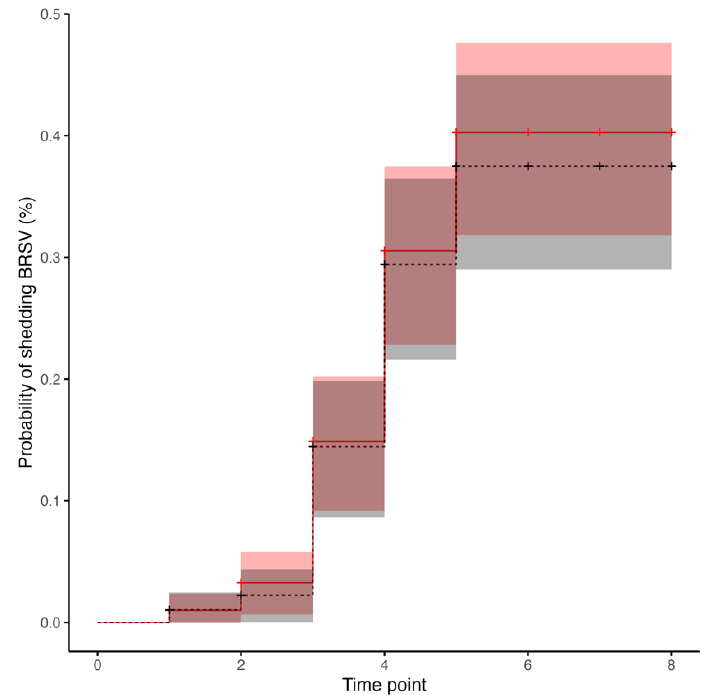
Figure 5. Kaplan–Meier curves of the cumulative probability of shedding Bovine Respiratory Syn- cytial virus (BRSV) detected by real time-RT-PCR assay on time intervals 0 to 8, in which each time interval is representing days 0 to 2, 2 to 4, 4 to 6, 6 to 8, 8 to 10, 10 to 14, 14 to 21, and 21 to 28 after BRSV challenge of calves vaccinated intranasally (IN) with a modified-live virus (MLV) BRSV vaccine in the first 6 h of life (dashed line and triangles) versus control calves (solid line and circles) subsequently challenged with BRSV. Tick marks represent the end of each time period, each step represents detection events of BRSV shedding, and shading represents the respective 95% CI for the probability of shedding BRSV by vaccinated (red) versus control (gray) calves.